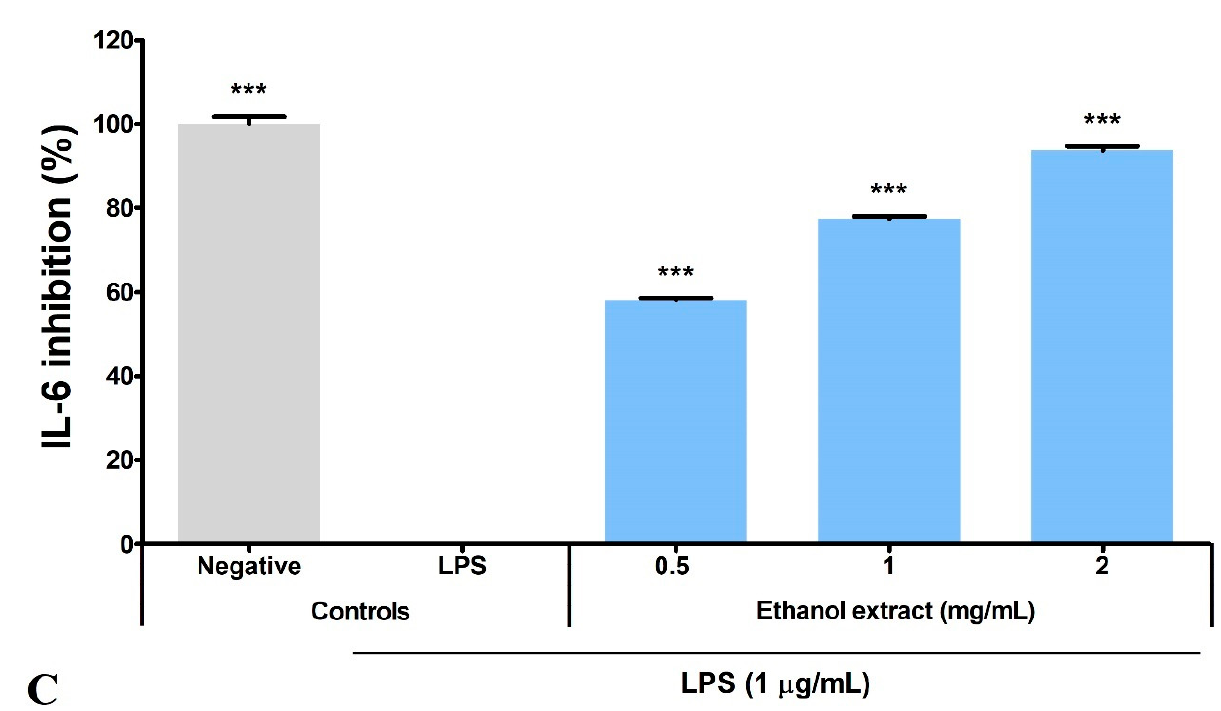
Figure 4. Inhibitory activity of S. platensis ethanol extract on the proinflammatory mediator and cytokines production in LPS-induced BV2 microglia. Dose-dependent effects were observed on the production of ( A ) PGE 2 , ( B ) TNF- α and ( C ) IL-6. The inhibitory activities were expressed as a per- centage of the negative control. Data represented the mean ± SE ( n = 3). *** p ≤ 0.001 significant difference in inhibitory activity relative to the LPS control by Dunnett’s multiple comparison test.